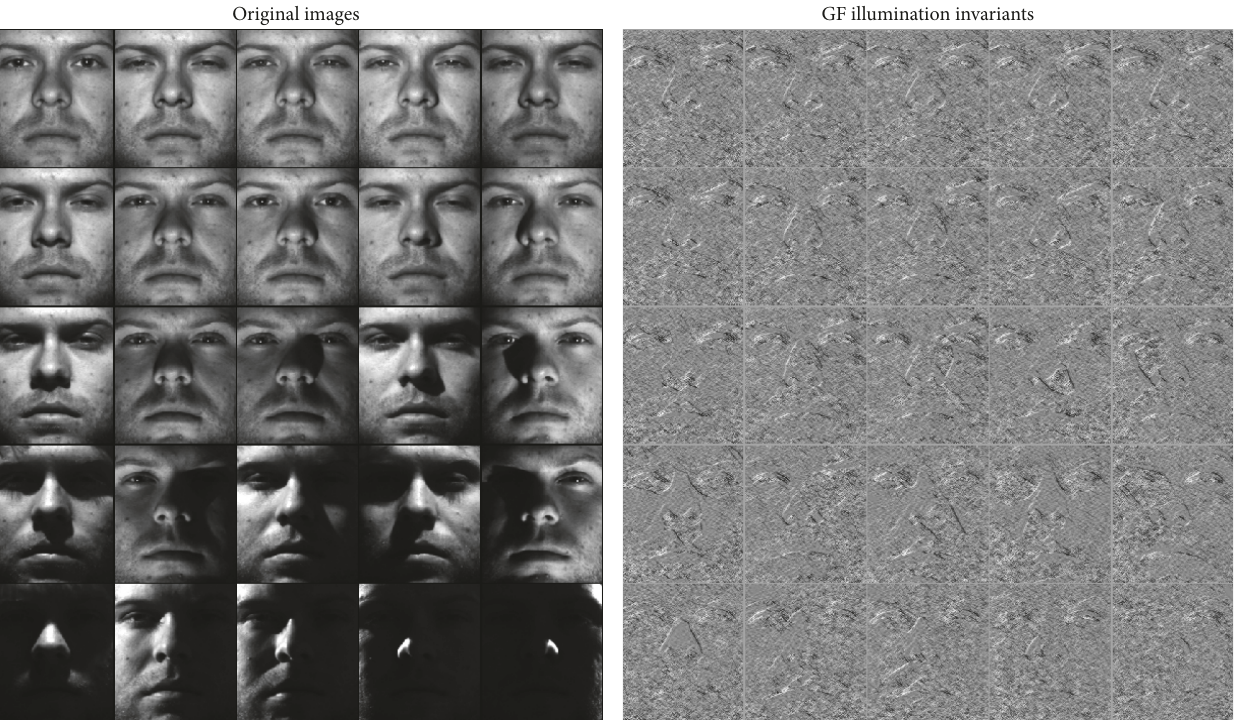
Figure 4: Images of subsets 1–5 and their illumination invariants using GF.